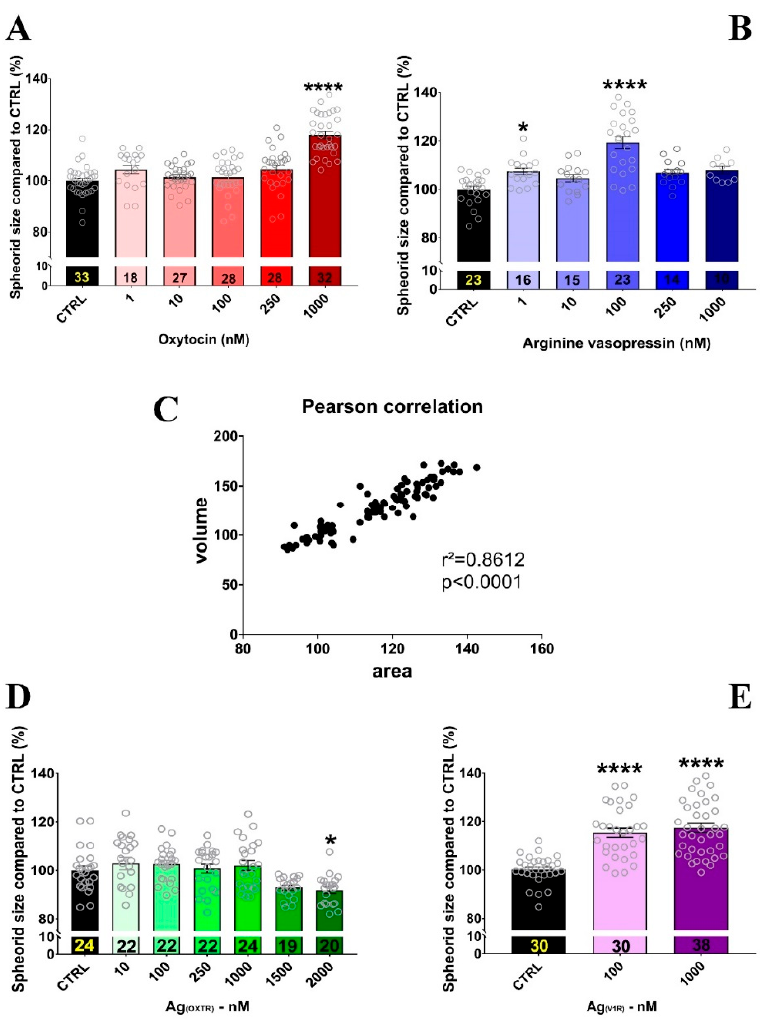
Figure 3. Effects of a 3-day treatment regimen of OXT, AVP, and their cognate receptor agonists on H32 neurospheroid size. ( A ) Only 1000 nM OXT was effective in significantly increasing spheroid size by 118%. One-way ANOVA (F (5,160) = 28.53, p < 0.0001); Holm–Sidak **** p < 0.0001 compared to the control (CTRL) group. ( B ) AVP increased spheroid size at 1 nM and 100 nM, but not 10, 250, or 1000 nM. One-way ANOVA (F (5,95) = 16.38, p < 0.0001); Holm–Sidak * p < 0.05 and **** p < 0.0001 compared to CTRL. ( C ) The measured spheroid volume was significantly and positively correlated with the surface area of the spheroids (r 2 = 0.8612, p < 0.0001), indicating a positive effect of OXTR and V1aR on spheroid size and surface area. ( D ) Treatment with the OXTR agonist TGOT (Ag (OXTR) ) reduced spheroid size at 2000 nM. One-way ANOVA (F (6,146) = 5840, p < 0.0001); Holm–Sidak * p = 0.0317 versus CTRL. ( E ) Treatment with a vasopressin receptor agonist (Ag (V1R) ) at 100 and 1000 nM increased spheroid size. One-way ANOVA (F (2,95) = 29.07, p < 0.0001); Holm–Sidak **** p < 0.0001 compared to CTRL.